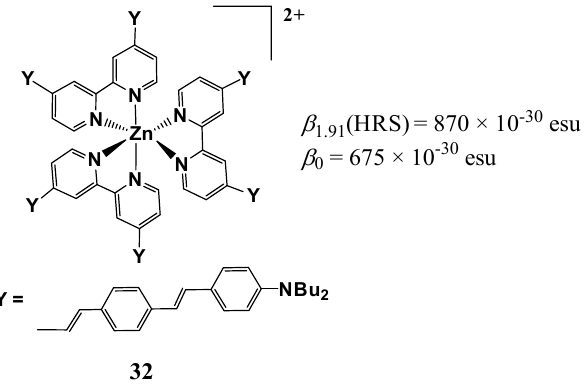
Figure 9. Structure of 32 displaying the highest NLO activity.